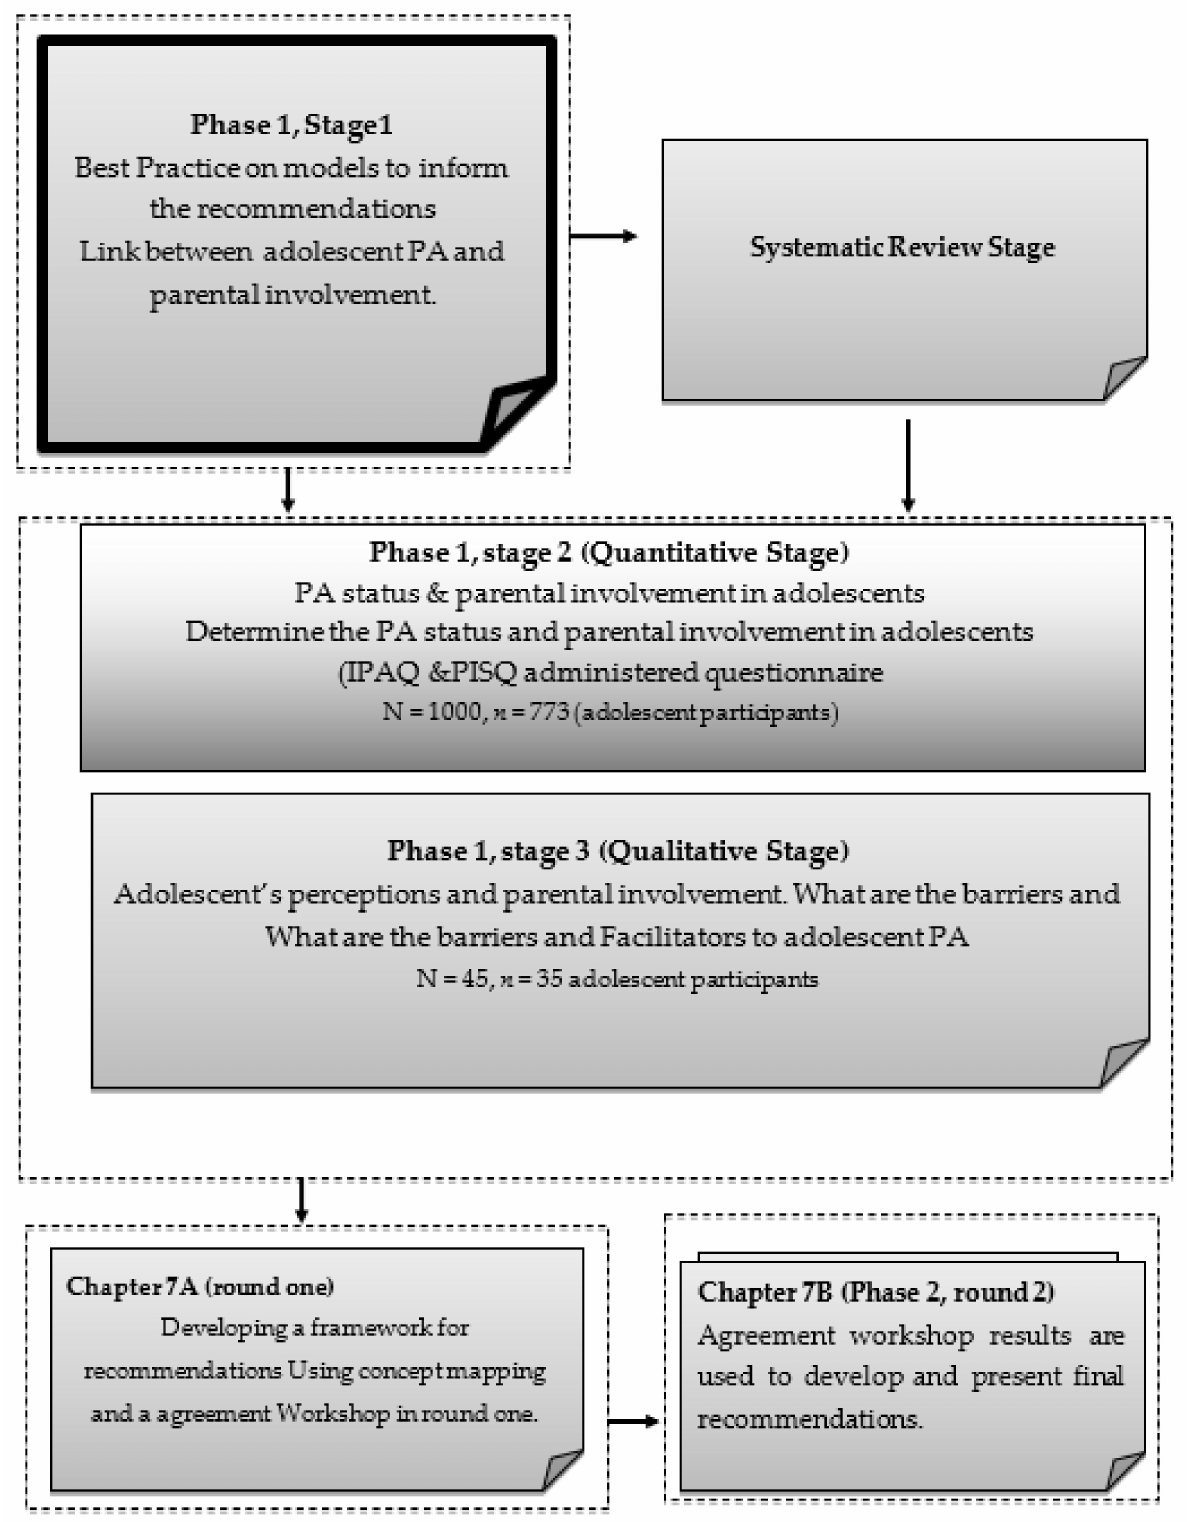
Figure 1. The pre-study